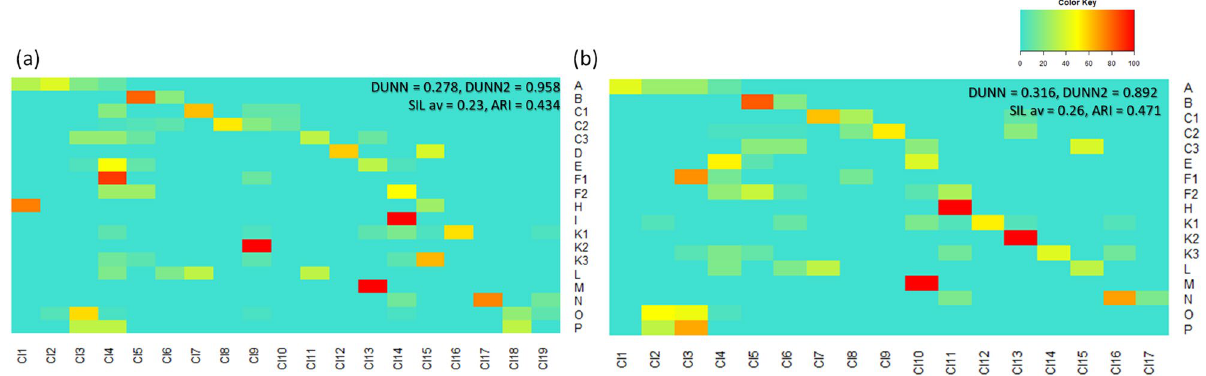
Figure 2. Heat map presentations and evaluation metrics for distributions of ( a ) HRAC2020 + HRAC_REST (411) and ( b ) HRAC2020 (314) herbicides in terms of fractions (%) of MoA classes in clusters generated by the agglomerative algorithm and MACCS